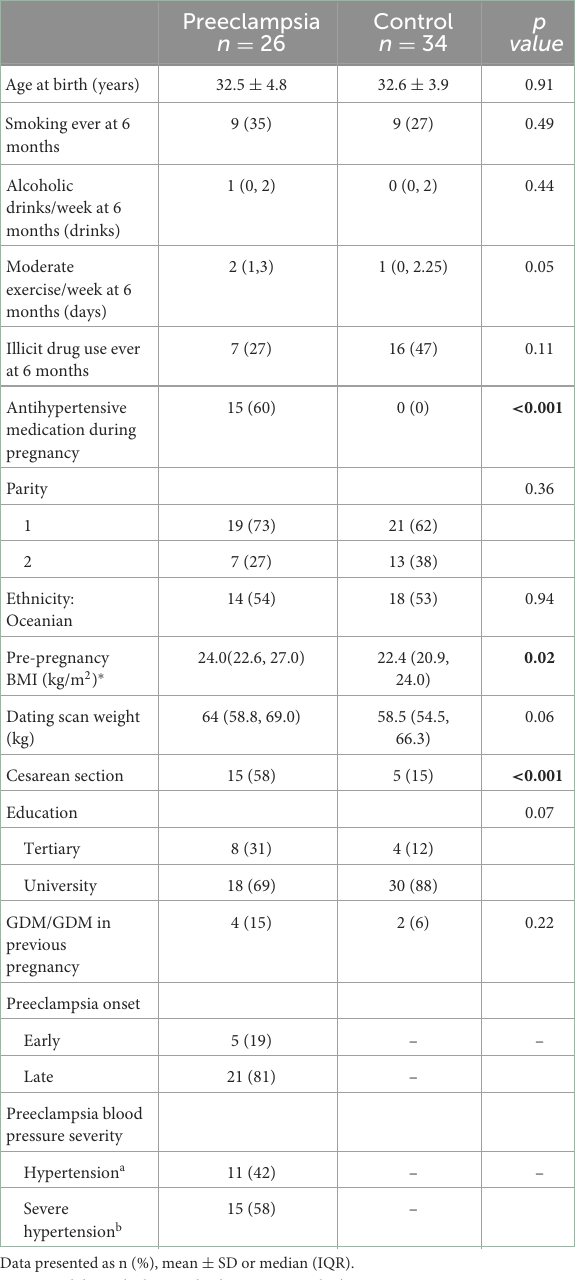
TABLE 3 Maternal characteristics stratified by preeclampsia vs. normotensive